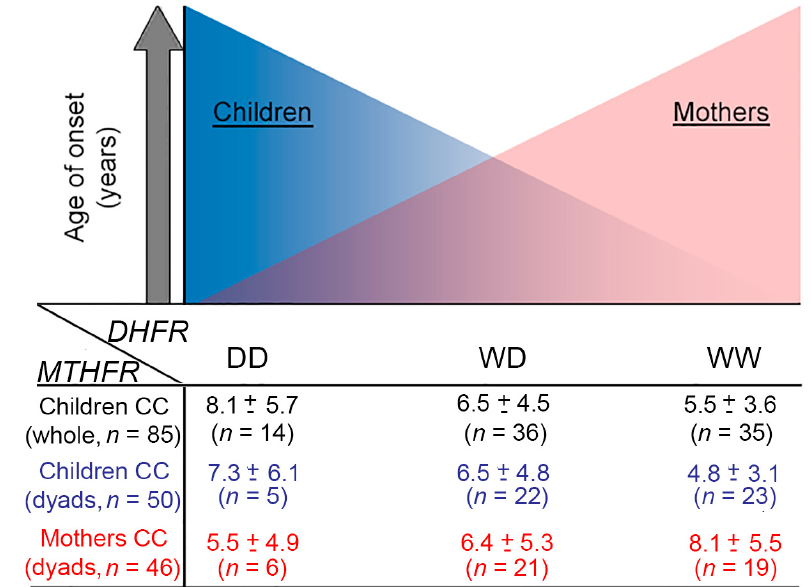
Figure 2. DHFR genotype effect on ALL (acute lymphoblastic leukemia) onset age according to the carrier. Schematic representation summarizing the hypothesized axis observed between DHFR gene variant and ALL onset age leading to opposite directions according to the carrier ( Upper Panel ). Mean values of ALL onset age (mean ± SD) according to DHFR genotype in the whole cohort (black), in the dyad-children (blue), and mothers (red) subgroup ( Lower Panel ). The DHFR / MTHFR 677 genotype combinations are referred to children or mothers genotype as indicated.